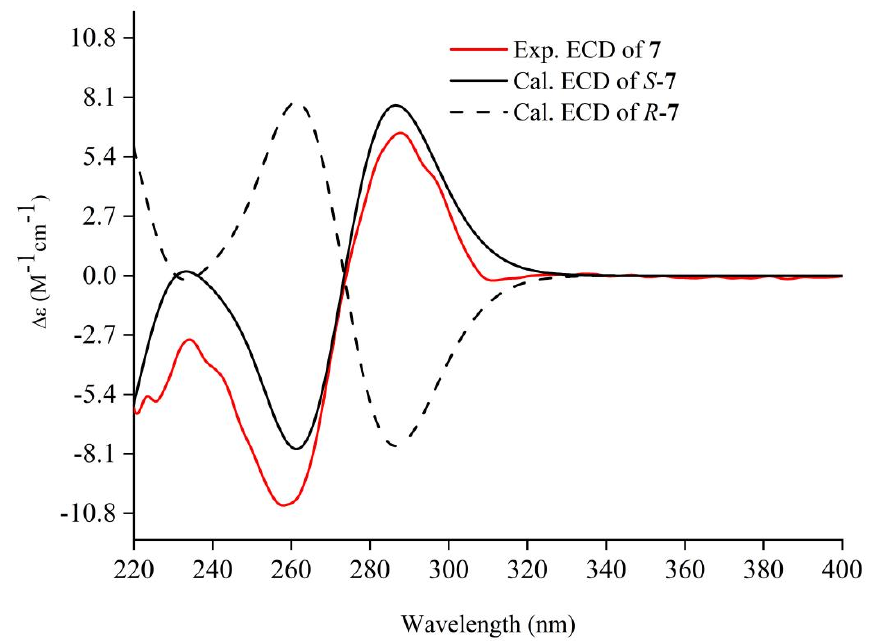
Figure 6. Experimental ECD spectra (200–400 nm) of 7 in methanol and the calculated ECD spectra of the model molecules of 7 at the PBE0/def2-TZVP level. Table 2. The 1 H, 13 C, HMBC, and HSQC NMR data for compound 7 in CD 3 OD.